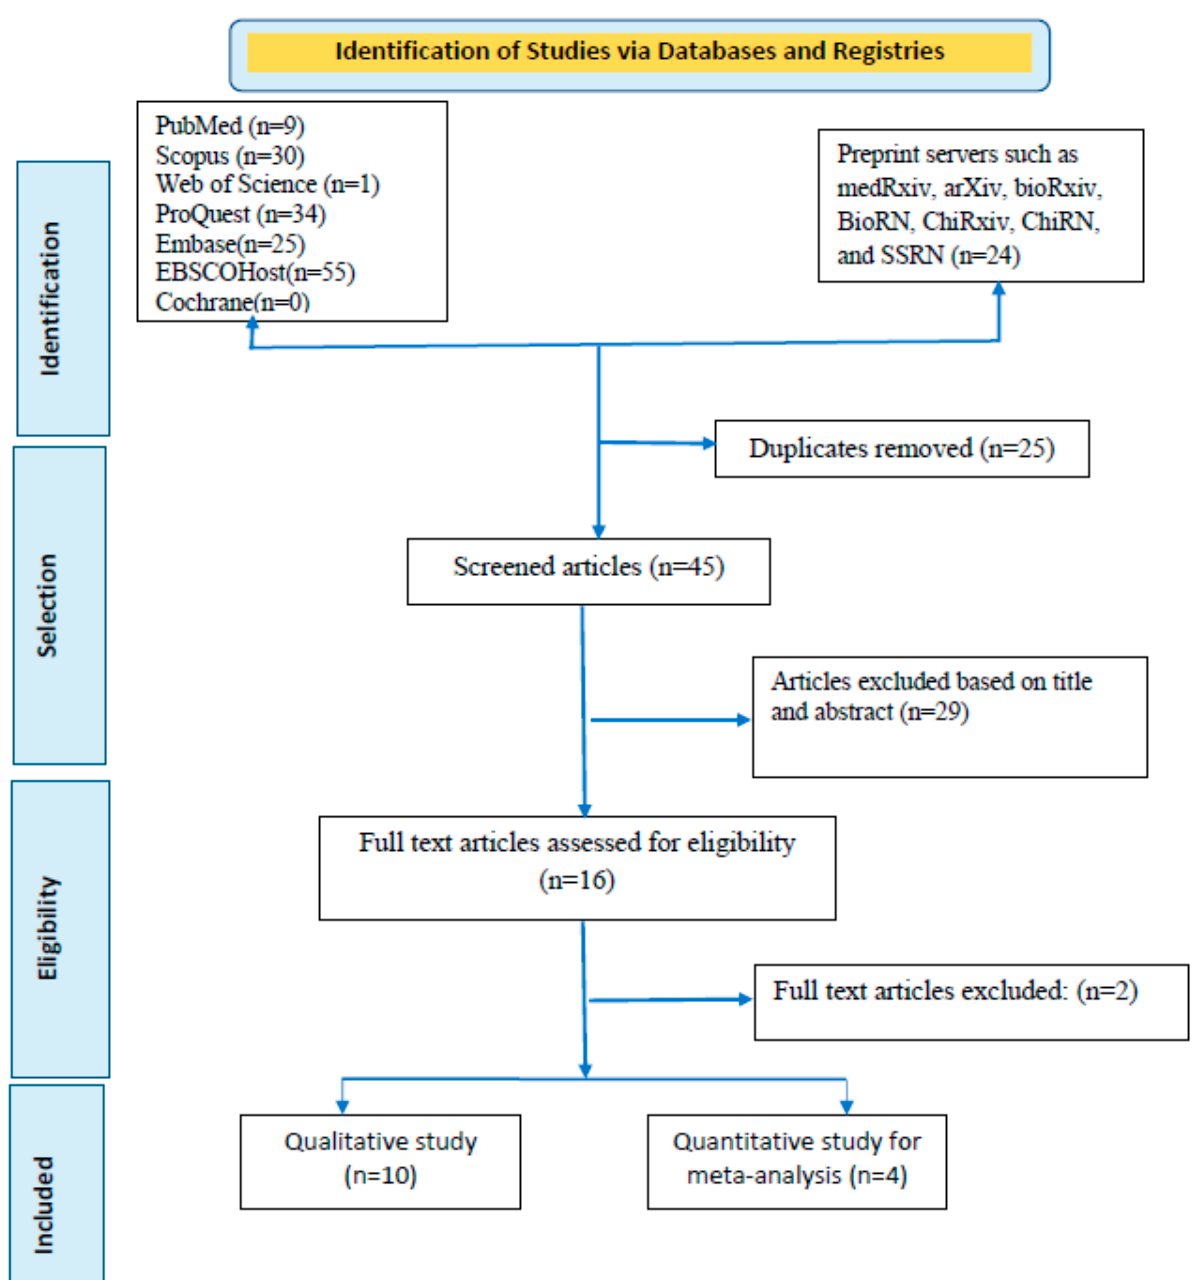
Figure 1. PRISMA flowchart for included studies in systematic review and meta-analysis of asymp- tomatic infection and transmission of monkeypox virus.